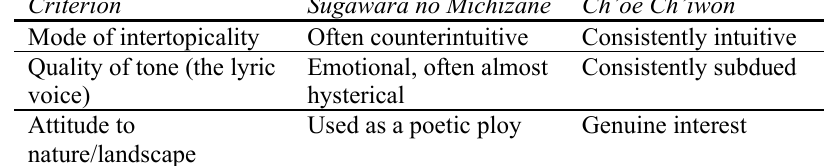
Table 1. A comparative analysis of the poetics of Sugawara no Michizane and Ch’oe